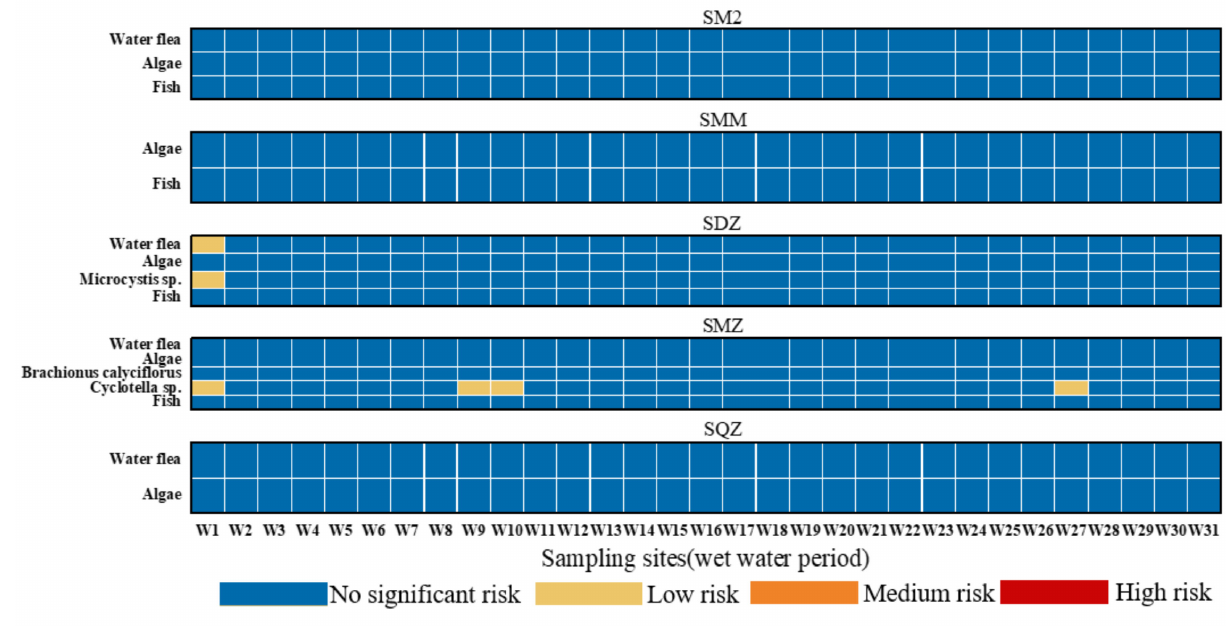
Figure 7. The RQ s of SAs in Shaanxi section of the Weihe